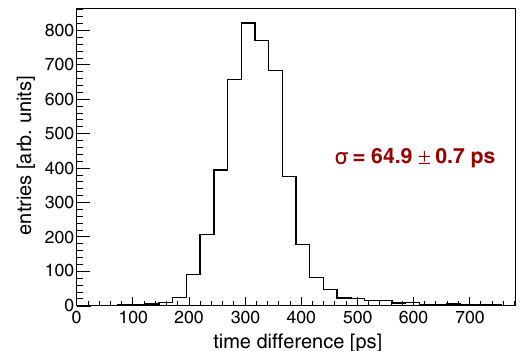
FIG. 4. Distribution of time difference on the TDC between the MCP signal and laser-synchronized signal. The standard deviation of the distribution corresponds to the time resolution of the BWM. This result was obtained with the typical HV ¼ − 2320 V and V ¼ − 480 setting, V in out